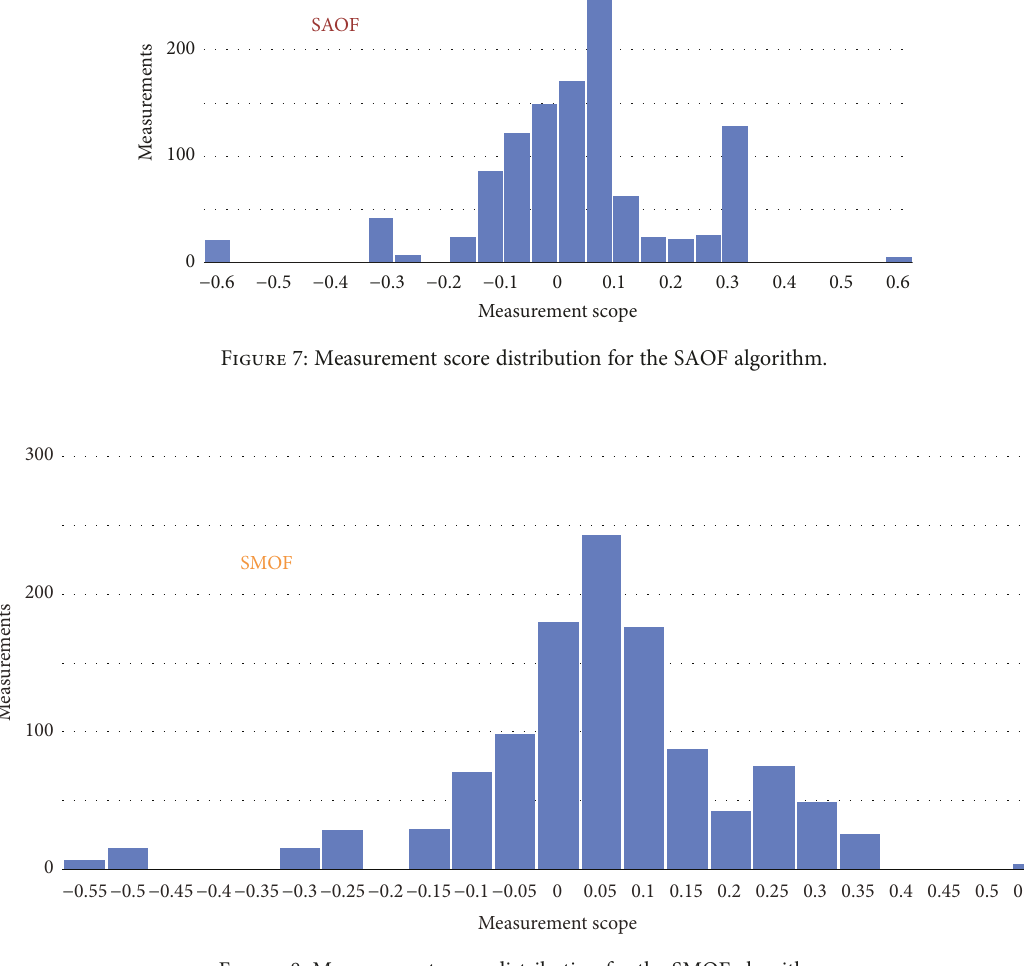
Figure 8: Measurement score distribution for the SMOF